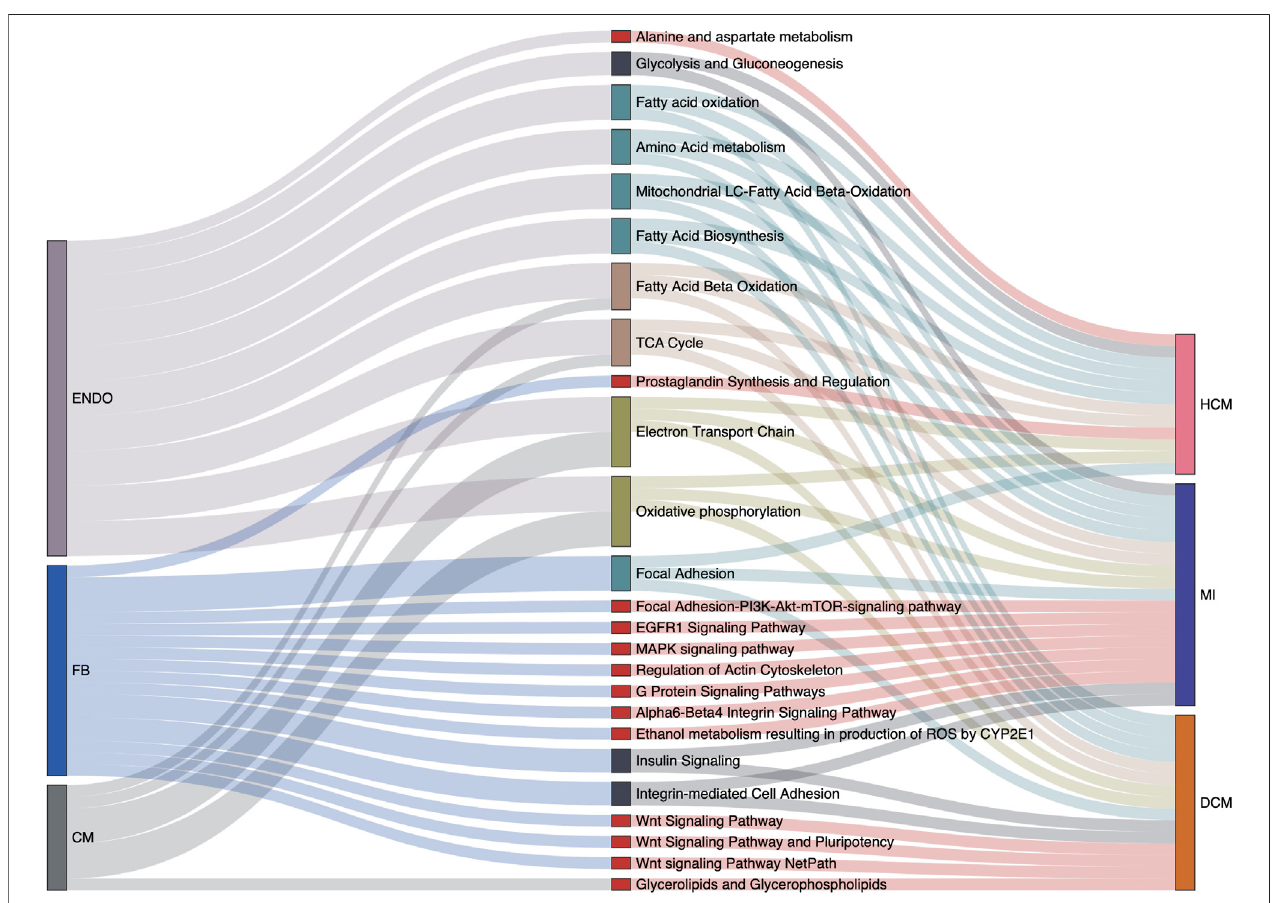
FIGURE4| Celltype-speci fi coverrepresentedpathways associatedwithvariouscardiac disease conditions.Relationsamongcelltypes, signaling pathways from the WikiPathways database, and disease conditions are summarized in the Sankey plot. Only the pathways signi fi cantly enriched at least among one of the cell-speci fi c differentially expressed gene (DEG) sets in one disease condition are considered. Besides this, pathways actually describing disease gene sets are excluded to avoid confusion. The width of a link correlates with the strength of the relation ( i . e ., the relative counts of pathway genes in the DEGs of a speci fi c cell type or a speci fi c disease